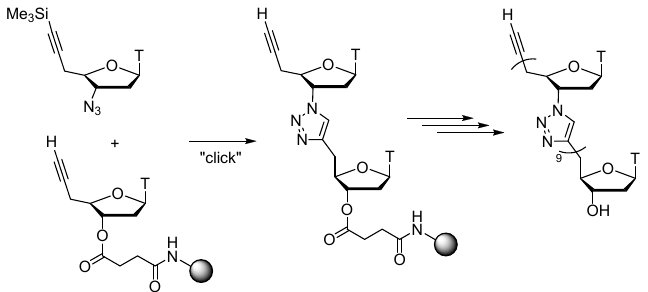
Scheme 8. Solid-phase synthesis of 10-mer TL